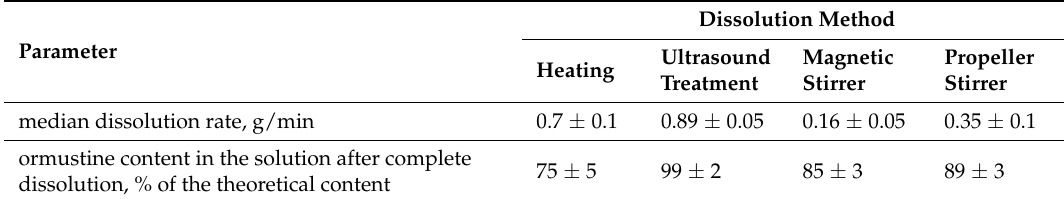
Table 2. Effect of different methods on the rate of dissolution of the ormustine